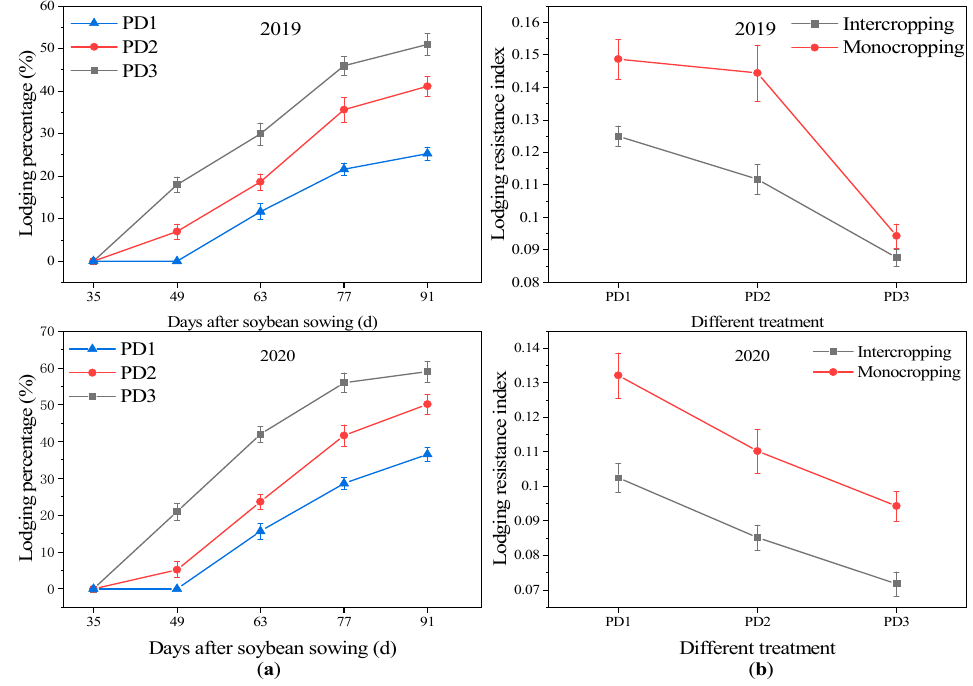
Figure 2. E ff ects of multiple planting densities (PD1 = 17, PD2 = 20, and PD3 = 25 plants m − 2 ) on the lodging percentage ( a ) and lodging resistance ( b ) under both monocropping and intercropping. All the values are means ( ± SE) standard error of three replications.